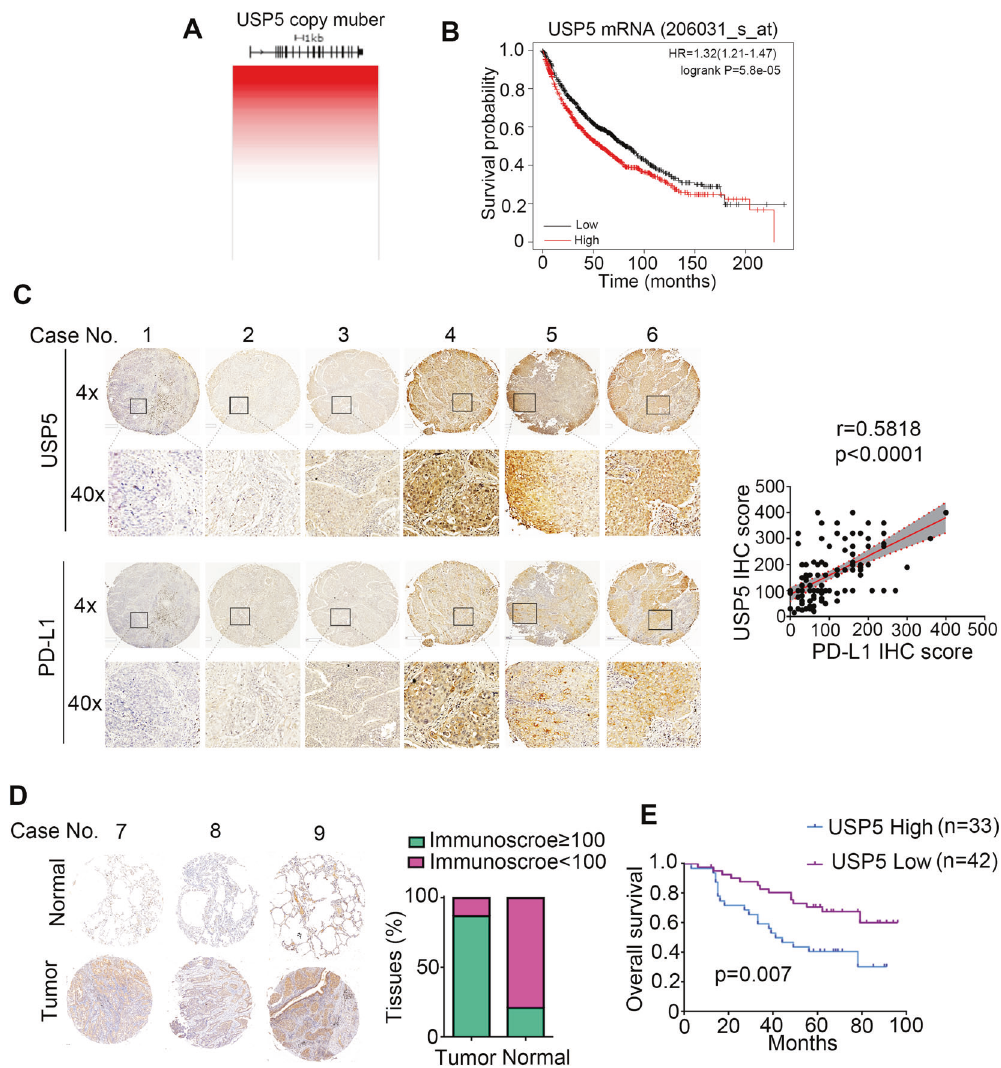
Fig. 6 USP5 is overexpressed and highly associated poor prognosis in NSCLC patients. A Copy number analysis of USP5 in TCGA lung adenocarcinoma. B Kaplan – Meier survival plot of USP5 mRNA in lung cancers using KM plotter (https://kmplot.com/). C IHC analysis of PD-L1 and USP5 protein levels in NSCLC tissues. The correlation between USP5 and PD-L1 in NSCLC patient tumors ( n = 112) was explored using Pearson correlationanalysis. D IHC staining of USP5 was compared in NSCLC tissues and normal lung tissues. E Kaplan – Meier survival curve of USP5 protein expression in NSCLC patients, n =